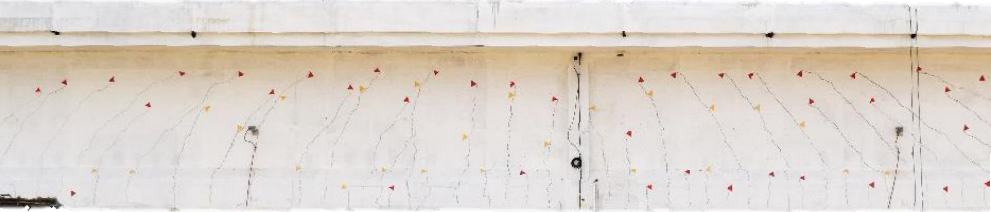
Figure 12. Visible cracks on girder T1 opened during the loading phase P4 7200 kN.